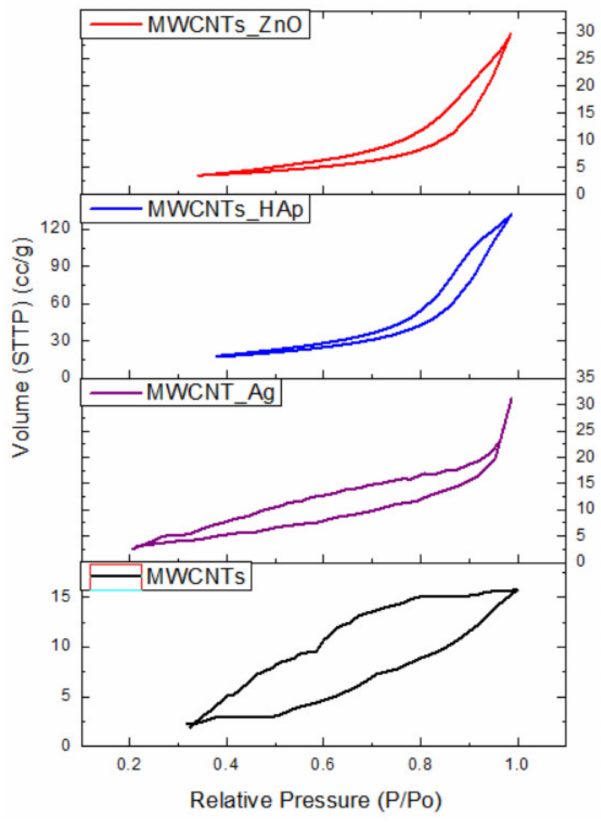
Figure 8. Isotherm curves of the MWCNTs and decorated